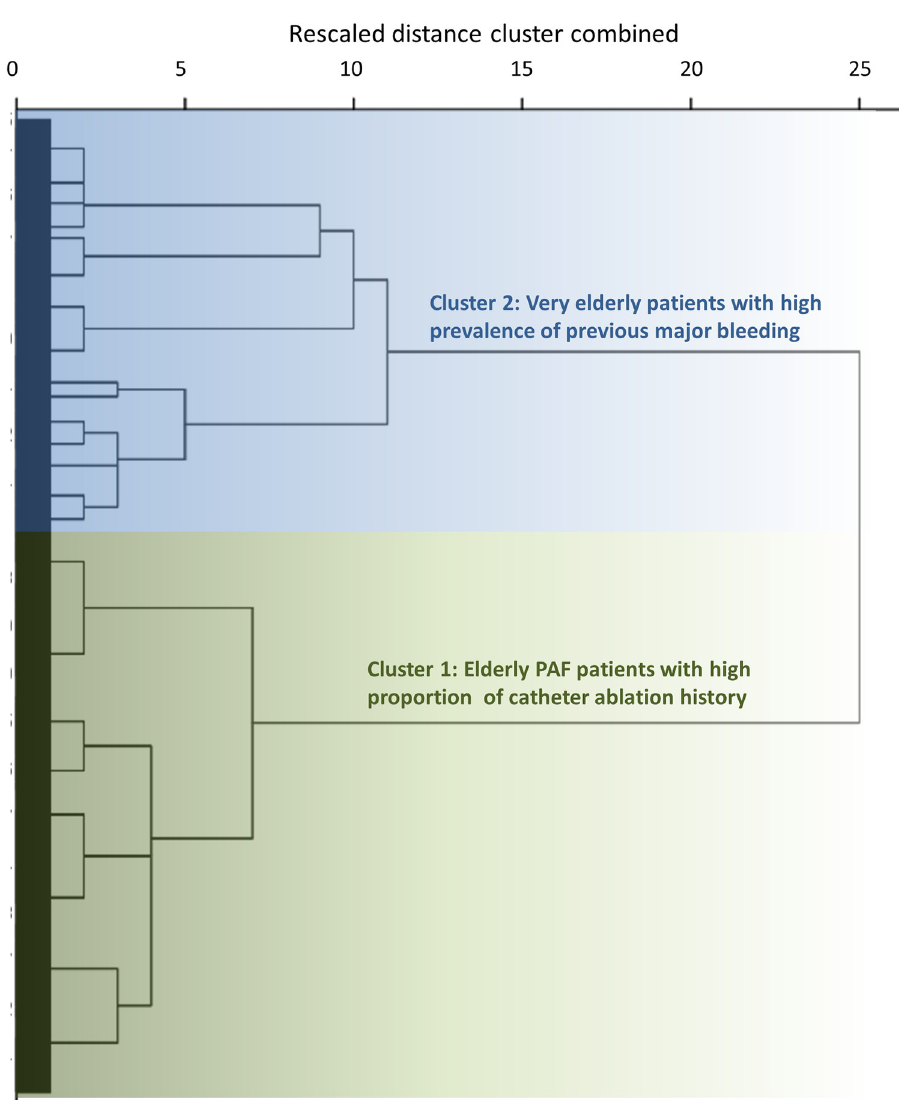
Fig 1. Dendrogram of the hierarchical cluster analysis. Abbreviation: PAF, paroxysmal atrial fibrillation.